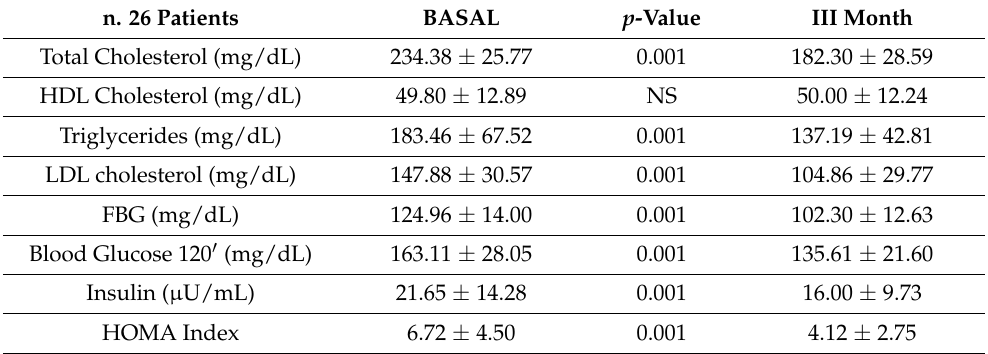
Table 2. Laboratory parameters before and after lifestyle modifications (Mean ± Standard